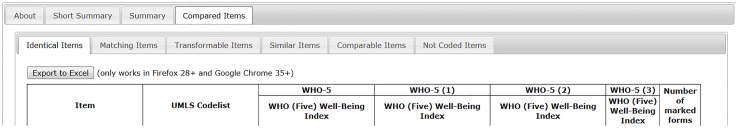
Result of multiple forms comparison.